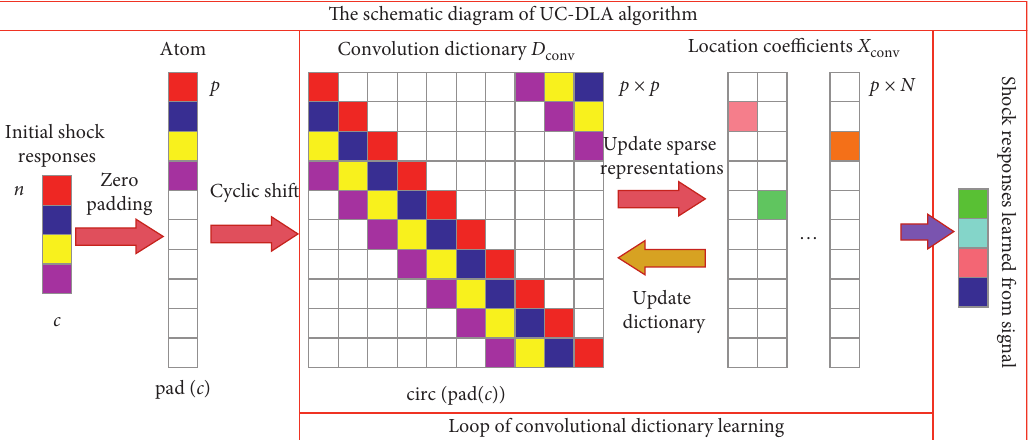
Figure 2: The schematic diagram of UC-DLA